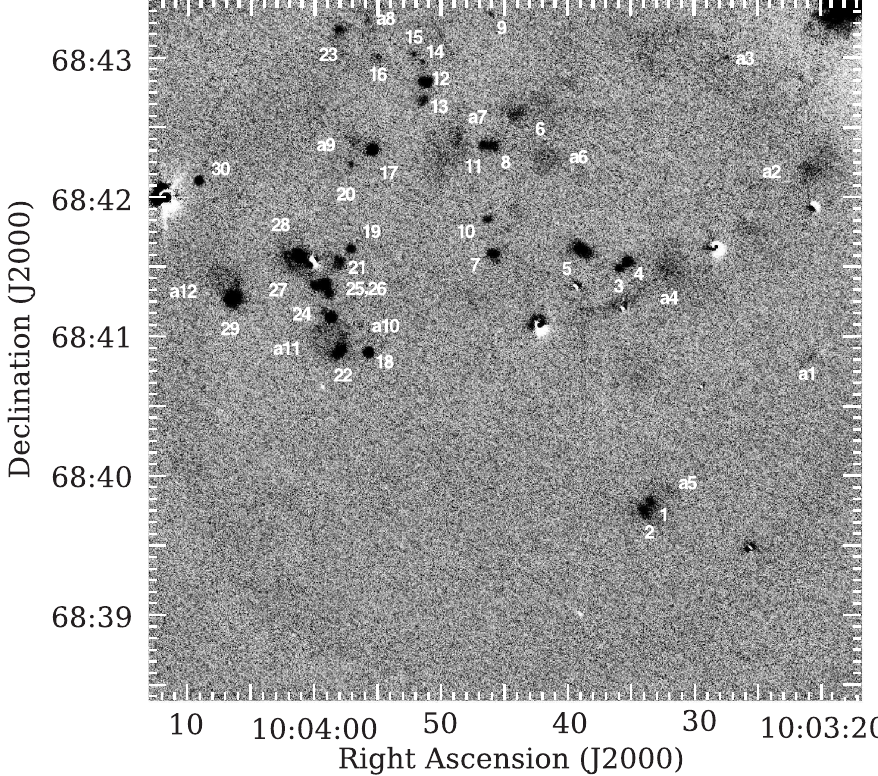
Fig. 1. The continuum-subtracted H (cid:11) image. New H II region candidates and objects used for the (cid:13)ux calibration (Walter et al. 2006) are numbered.